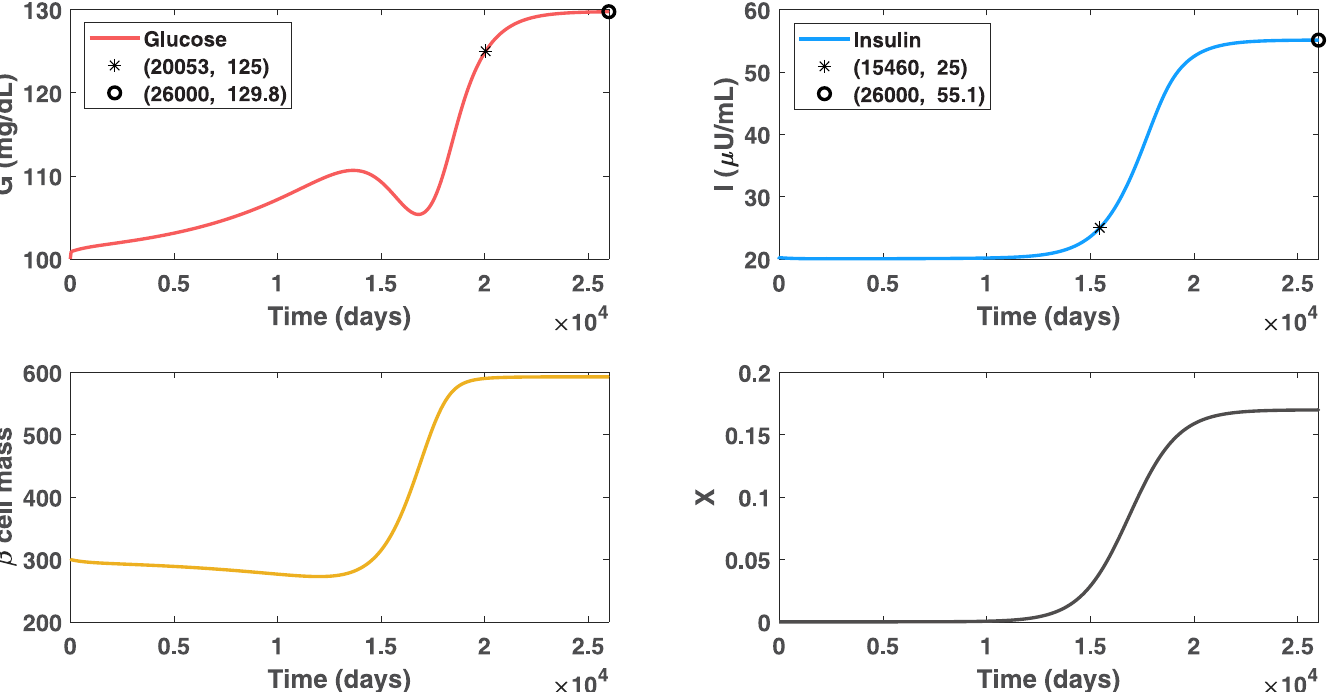
Fig 4. Dynamics of glucose, insulin and functional beta-cell mass level for patient A with mild obesity ( X approaches 0.17 progressively). This figure describes the impact of the controlled obesity-related factor on the alleviation of diabetes. In contrast to the occurrence of beta-cell failure and subsequent insulin deficiency in Fig 2, hyperinsulinemia would occur to patient A on day 15460 and stay in the remainder of the life of this patient with undamaged pancreatic function. The glucose levels can be controlled below 125 mg/dl before day 20053, indicating a deferral of 38 years to develop diabetes compared with the condition in Fig 2. In addition, a moderate glycemic level, less than 130 mg/dl, can be maintained in the later life of this patient.